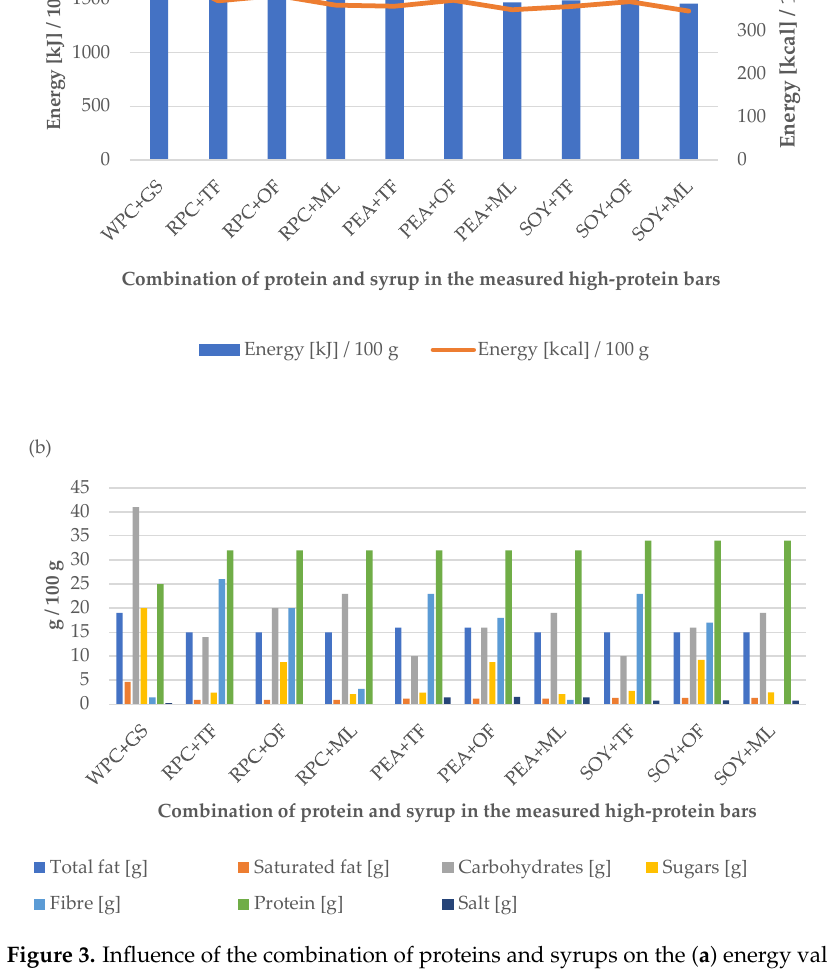
Figure 3. Influence of the combination of proteins and syrups on the ( a ) energy value and ( b ) nutritional value of the developed high-protein bars.